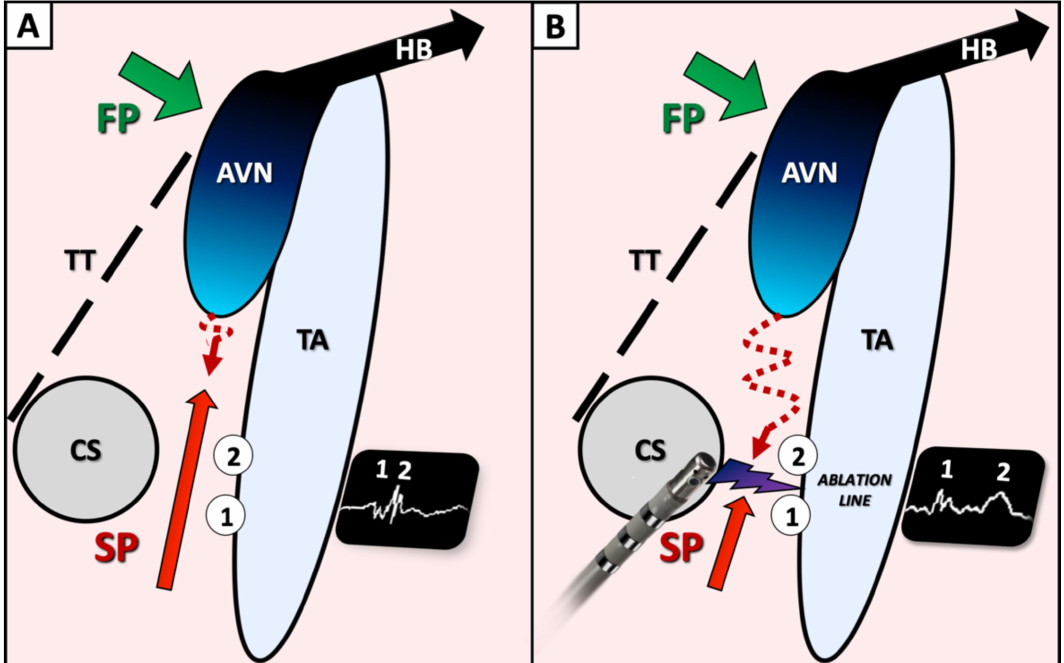
Figure 5. Schematic view of Koch triangle, prior ( A ) and following ( B ) ablation of the slow pathway proposing an explanation of double potentials visualization. During ablation, gradual split of the so- called slow pathway potential ( A ), leading to a double potential can be observed on the ablation line ( B ). The first potential (1) might represent the anterograde activation through the proximal portion of the slow pathway, below the ablation line, while the second potential may represent the late retrograde activation of the distal part of the slow pathway, above the line. FP: fast atrioventricular nodal pathway; SP: slow atrioventricular nodal pathway; CS: coronary sinus ostium; TT: tendon